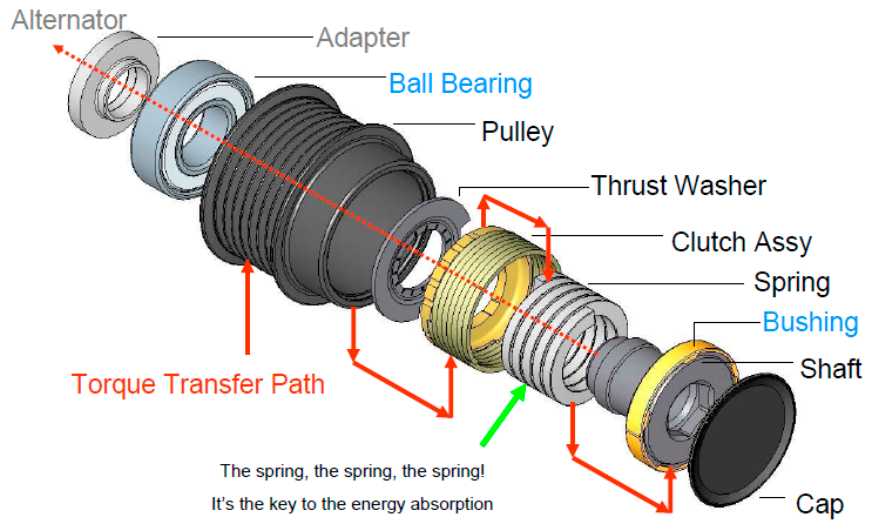
Figure 1. Schematic of one-way clutch alternator pulley.